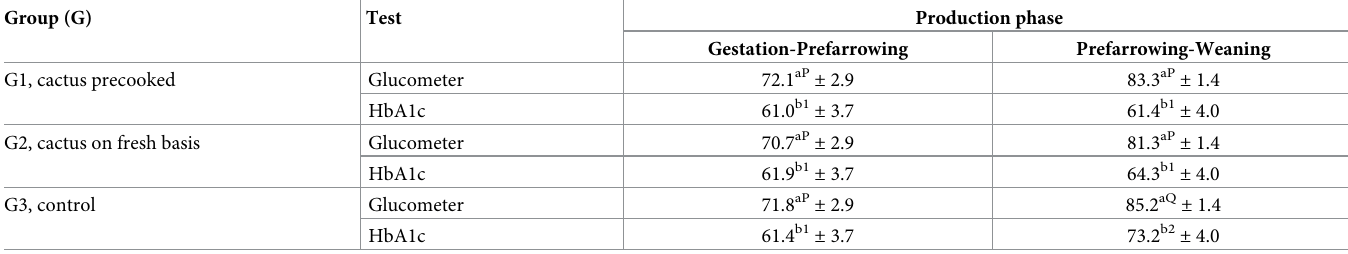
Table 3. Least squares mean ( ± SEM) for the average preprandial blood glucose concentration (mg/dL) and HbA1c (mg/dL) according to the group and production phase of the sows. Group (G)